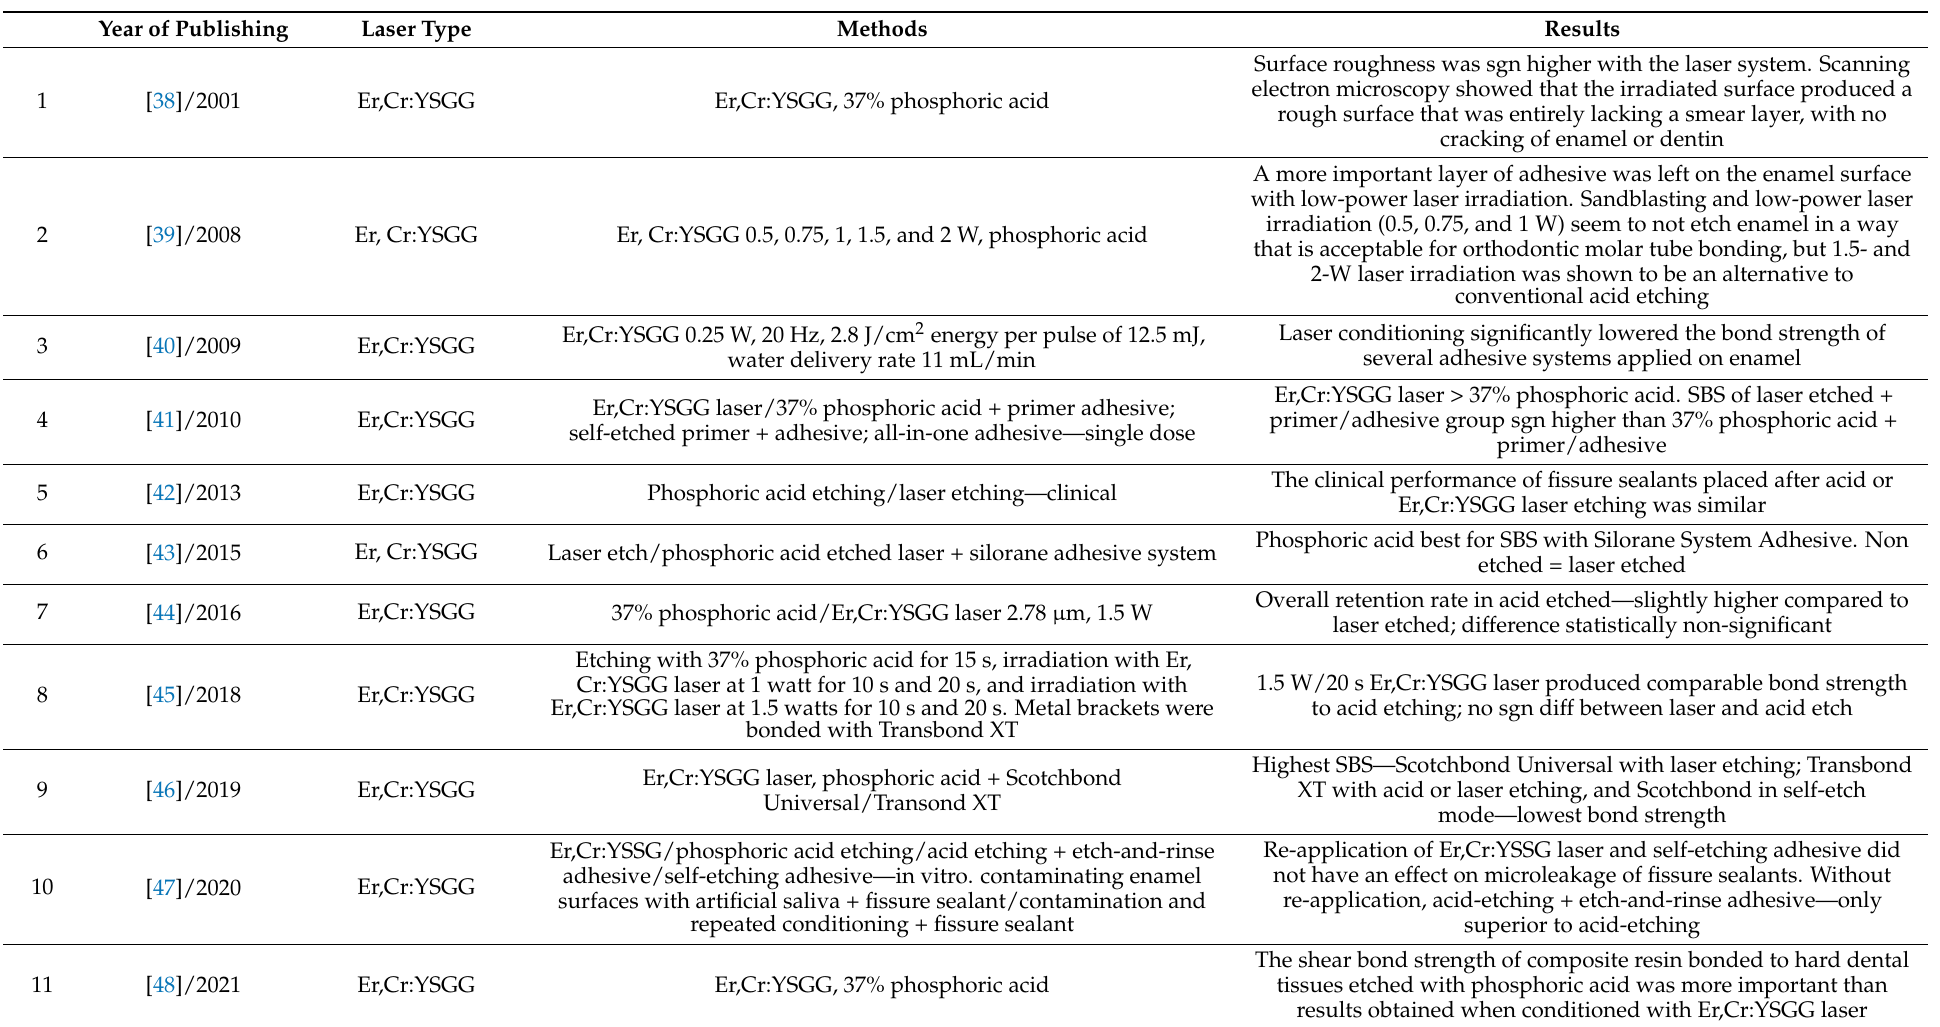
Table 3. Publications investigating Er,Cr:YSGG laser for enamel